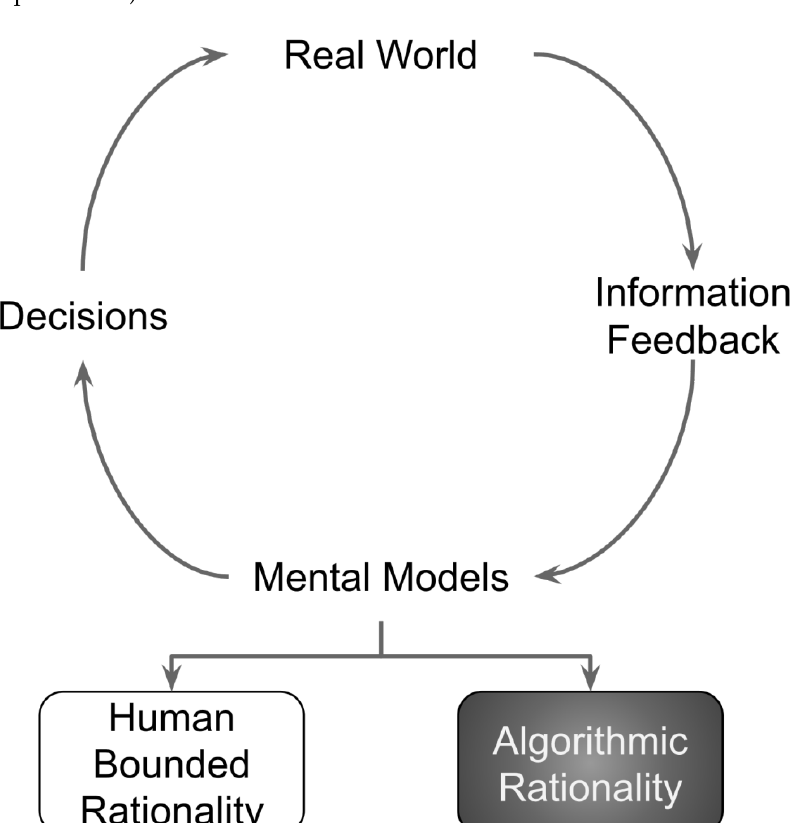
Figure 16. Causal modeling engenders asking relevant “ why ” questions to make algorithmic ra- tionality less opaque.